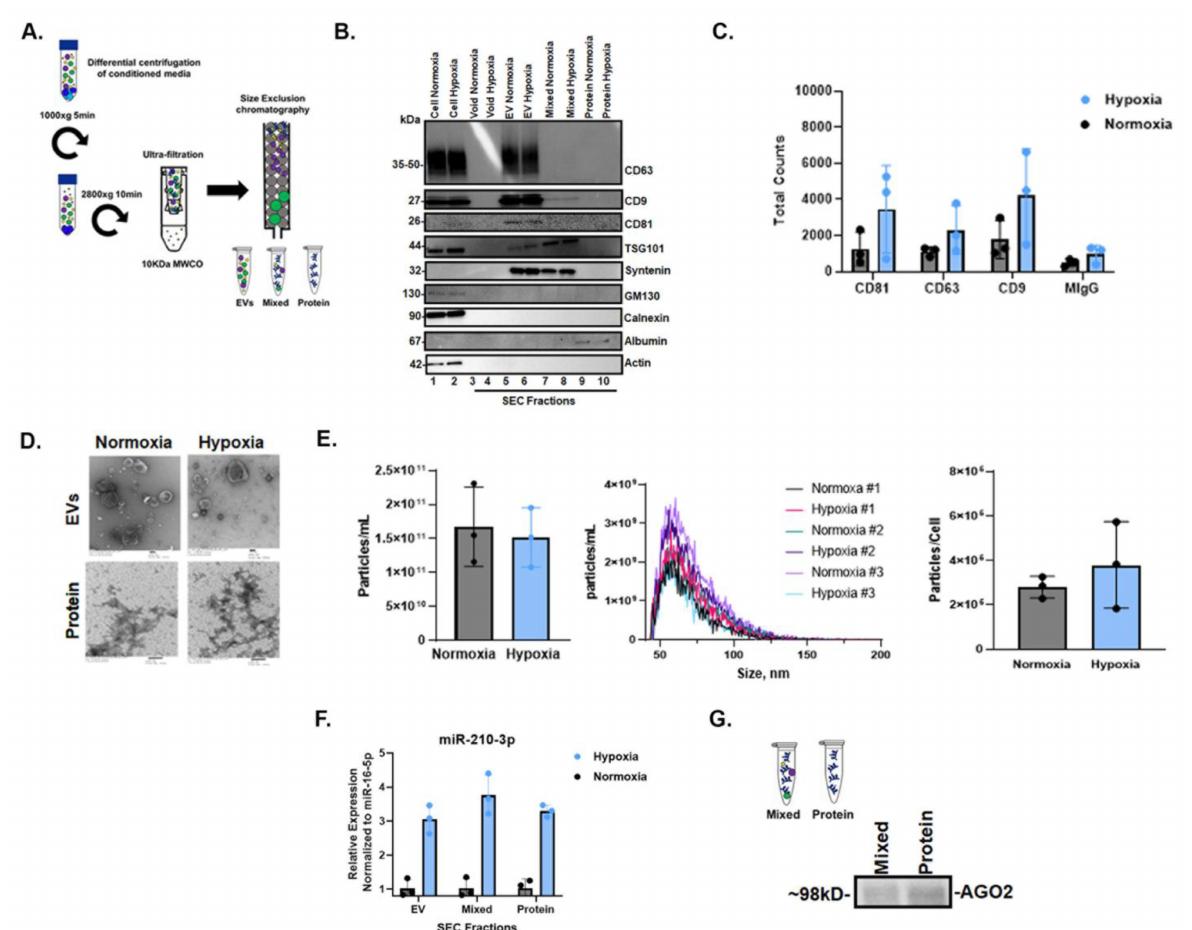
Figure 4. Characterization of cellular and extracellular fractions and AGO2 detection in hypoxic SW1736 culture. ( A ). Workflow diagram schematic of EV and protein separation from SW1736 cell culture media (CCM) by differential centrifugation and size-exclusion chromatography (SEC). Three independent experiments were performed. ( B ). Western blot analysis of tetraspanin CD63 and CD81 expression in SW1736 cell lysates and enrichment in hypoxic and normoxic SEC fractions after 72 h. ( C ). SP-IRIS detection of tetraspanins CD81, CD63 and CD9 in hypoxic and normoxic EV-enriched SEC fractions after 72 h. ( D ). Transmission electron micrograph (EM) of hypoxic and normoxic EV and protein SEC fractions after 72 h. ( E ). The SEC EV fraction particle counts per cell from normoxia and hypoxia. Data points represent three independent experiments by nano-flow cytometry. ( F ). miR-210-3p SEC pooled EV, mixed and protein qPCR analysis after 72 h hypoxia or normoxia, derived from 100 mLs of culture media. Data points represent three independent experiments. ( G ). AGO2 detection in SEC mixed and protein fractions by immunoprecipitation followed by Western